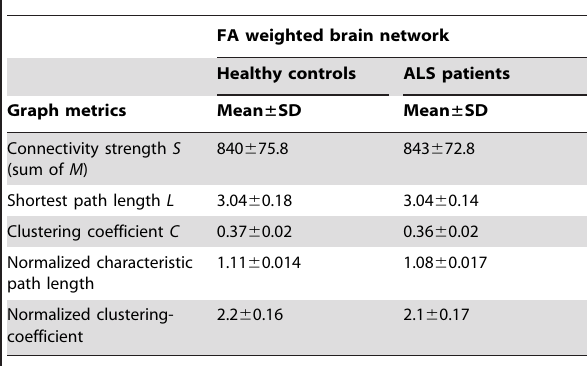
Table summarizes the global values of connectivity strength S, shortest path length L, normalized path length, and normalized clustering coefficient C (normalized to 100 random graphs). FA=fractional anisotropy. SD=standard deviation. overlap with regions that are known to play a key role in motor movement and control. To further examine this overlap an additional analysis was performed (see below).